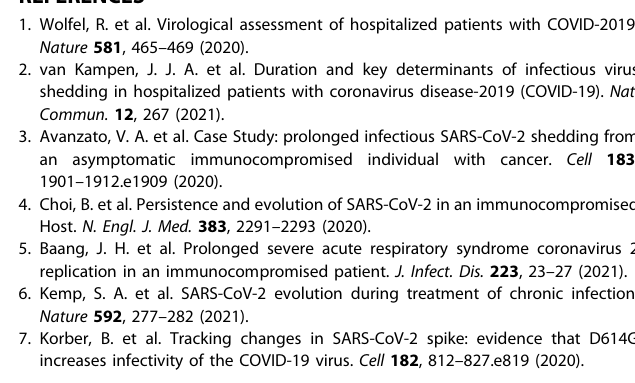
Fig. 1 Dynamic of viral RNA shedding and antibody and cellular response in prolonged asymptomatic SARS-CoV-2 infection in young adults. a Dynamic of the viral load in the nasopharyngeal swab samples of six prolonged asymptomatic cases (PCs) is indicated by the cycle threshold (Ct) values for SARS-CoV2 open reading frame 1ab (OFR1ab) and nucleocapsid protein (N) of real-time reverse transcriptase-polymerase chain reaction (RT-PCR). Dots indicate individual nasopharyngeal swab samples collected at the indicated days after the fi rst positive RT-PCR detection, and the whole viral genome successfully sequenced are indicated with red color. The asterisk indicates the positive detection of subgenomic RNA of SARS-CoV-2 in nasopharyngeal swab samples. b Dynamic of IgG levels against spike (S) and receptor-binding domain (RBD) of SARS-CoV-2 and pseudovirus neutralizing antibody (NAb) titer in serum from 6 PCs, 24 non-prolonged asymptomatic cases (NPCs), and 20 symptomatic cases (SCs). Dots represent individual serum samples collected at the indicated times, and the lines connect the samples from the same cases. A non-parametric loess function is shown as the blue line, with the gray-shaded representing the 95% con fi dence interval (CI). The geometric mean endpoint titers (purple line) and 95%CI are shown for the IgG and NAb at time points of serum sampling. c , d The total and SARS-CoV RBD-speci fi c IgG + memory B cell ( c ) and IFN- γ -producing T cell ( d ) response in PCs, NPCs, and SCs, and health controls (HCs). The left panel of c , d are representative ELISpot from each type of subject, with blank as negative control and anti-CD3 as positive controls. The right panel of c , d are cell counting in subjects. Data in the graph represented as spot-forming cells (SFC) per 1 × 10 6 PBMCs. Each point on the dot plot represents an individual subject. The bold black line represents the mean. e Cell surface immune phenotyping of B, NK, DC, and T cells by fl ow cytometry in PCs, NPCs, SCs, and HCs. Each dot represents the percentage of cellular responses for an individual. Boxplots indicate median, interquartile range, and 95%CI. f Correlations between Treg and activated CD4 + and CD8 + T cell. n = 6, 24, 20, and 20 for PCs, NPCs, SCs, and HCs, respectively. Two-tailed Kruskal – Wallis test with false discovery rate method was used for multiple comparisons in b – e . Statistical comparisons were performed using the two-sided nonparametric Spearman correlation for f . * p <